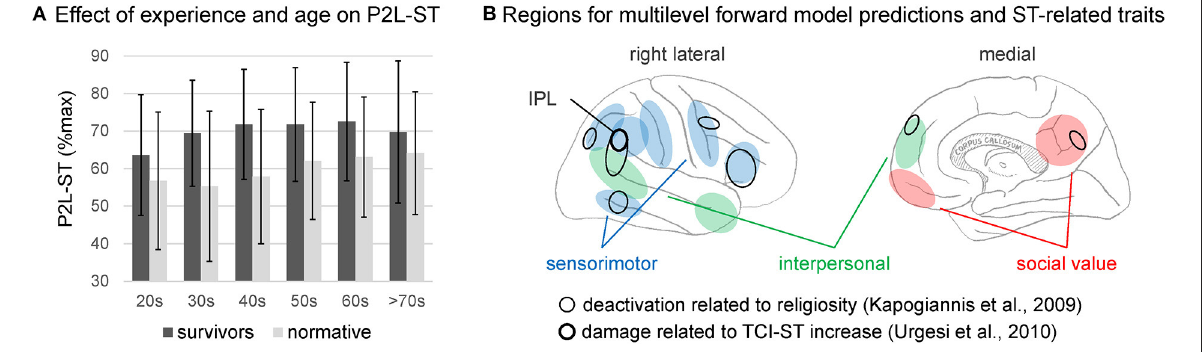
FIGURE1 (A) Average and standard deviation (error bar) of the score (%max) of self-transcendence (ST) factor of the power to live (P2L) questionnaire separately for six age levels (from 20s to over 70) and two groups: disaster survivors (dark gray) and normative population (light gray). (B) Cortical regions implicated in forward model prediction in the three-layer model of self-agency (Sugiura13) and those implicated in ST-related traits. Regions are schematically drawn on the lateral (left panel) and medial (left panel) surface of the right cerebral hemisphere. Regions for the sensorimotor, interpersonal, and social value levels in the three-layer model of self-agency are given in blue, green, and red, respectively. Damage related to the increase in the ST score of the TCI [Temperament and Character Inventory Cloninger et al., 1993] (Urgesi et al., 2010) and deactivation related to a higher perceived level of God’s involvement (Kapogiannis et al., 2009) are encircled by thick and thin lines,